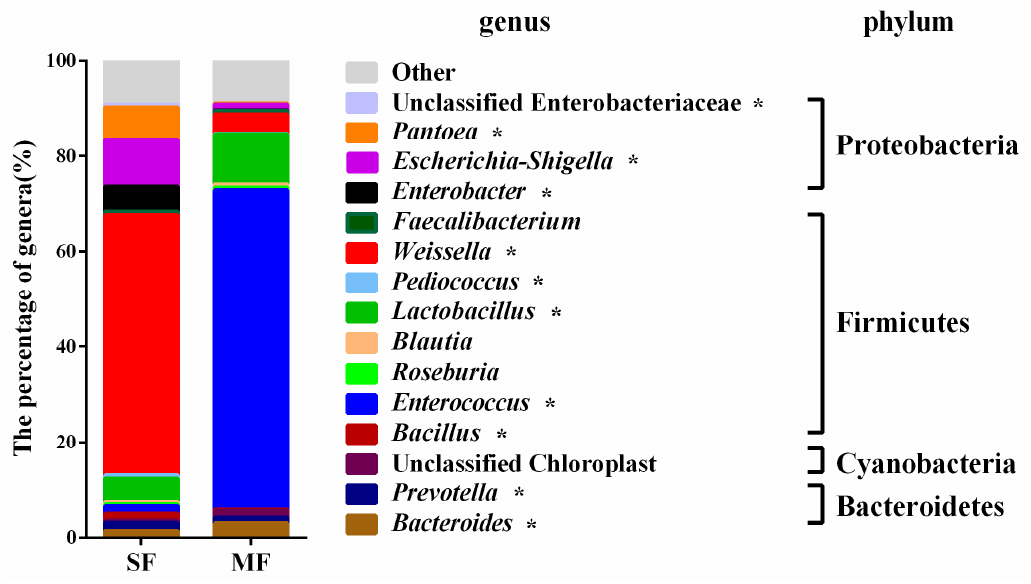
Figure 3. The average relative abundance at the genus level (% of total sequences) in fermented feed samples. Only genera with a relative abundance ≥ 0.5% in at least one treatment are shown.